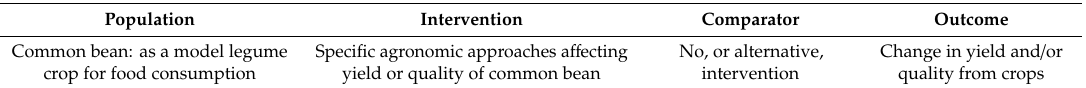
Table 2. The elements of the systematic review